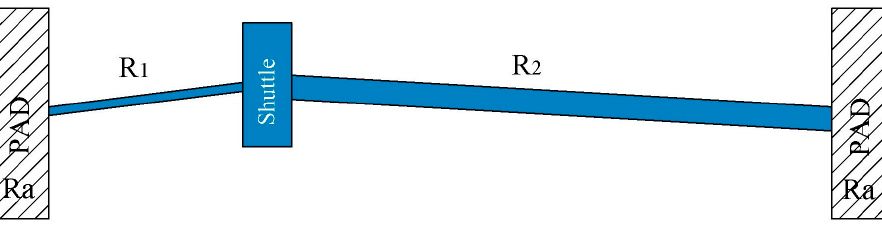
Figure 3. Resistances of asymmetric actuator.